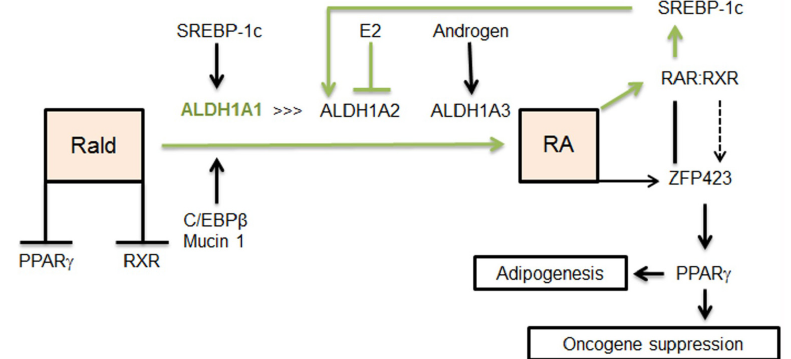
member A3; SREBP-1c, sterol regulatory binding protein 1; C/EBP β , CCAAT/ enhancer-binding protein beta; RA, retinoic acid; ZFP423, zinc finger protein 423; PPAR γ , peroxisome proliferator-activated receptor gamma; RXR, retinoid X